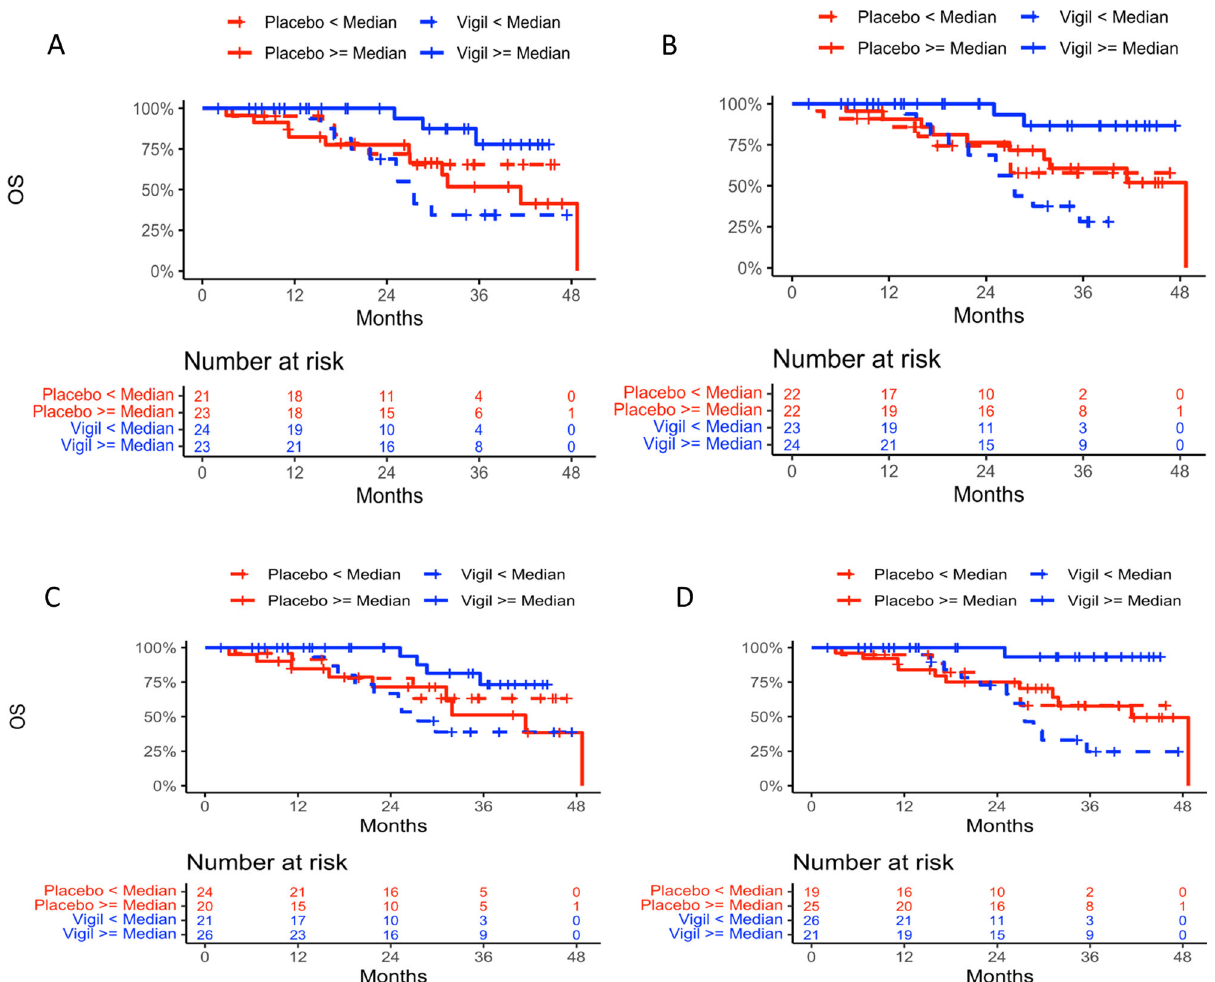
Fig. 3 Overall survival Kaplan Meier curves of all four genes analyzed. Overall survival Kaplan Meier curves of ENTPD1 / CD39 A , CCL13 B , CD79B C , and MRC1 D expression <median in Vigil ( n = 24, 23, 21, 26 respectively) and placebo ( n = 21, 22, 24, 19 respectively) and ENTPD1/CD39 , CCL13 , CD79B and MRC1 expression ≥ median in Vigil ( n = 23, 24, 26, 21, respectively) and placebo ( n = 23, 22, 20, 25, respectively) treated